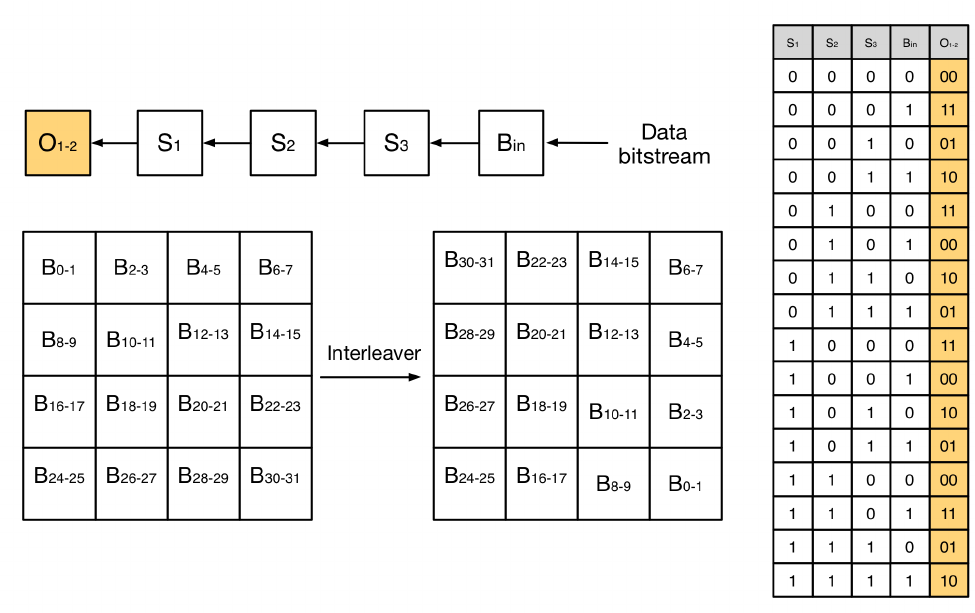
Figure 7. Forward error correction (FEC) coding schemes with the convolutional encoder and matrix